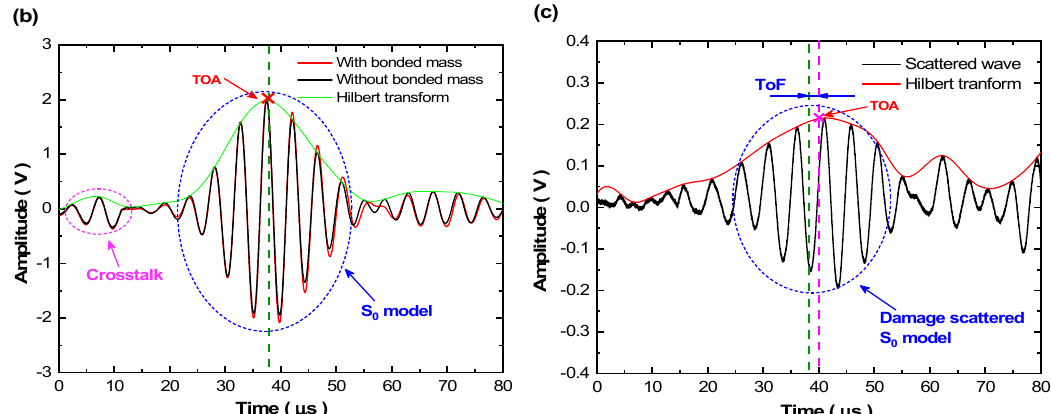
Figure 9. ( a ) Relative position of the actuator PZT 1 , sensor Sen 1 , and damage D 1 for the sensing path PZT 1 - Sen 1 ; ( b ) representative GUW signals acquired via the path PZT 1 - Sen 1 before and after introducing damage; ( c ) scattered wave extracted from these two GUW signals.